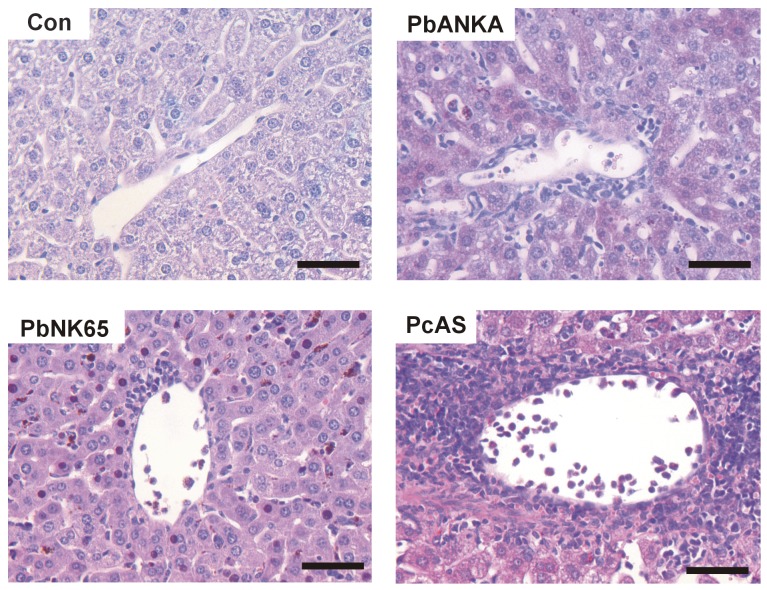
Massive inflammatory infiltrates in livers of PcAS-infected mice.Paraffin-embedded sections were prepared from livers of uninfected C57BL/6J mice (Con) and from mice infected with PbANKA (day 8), PbNK65 (day 10) or PcAS (day 10), and stained with hematoxylin–eosin. Representative images are shown (scale bars, 50 µm).